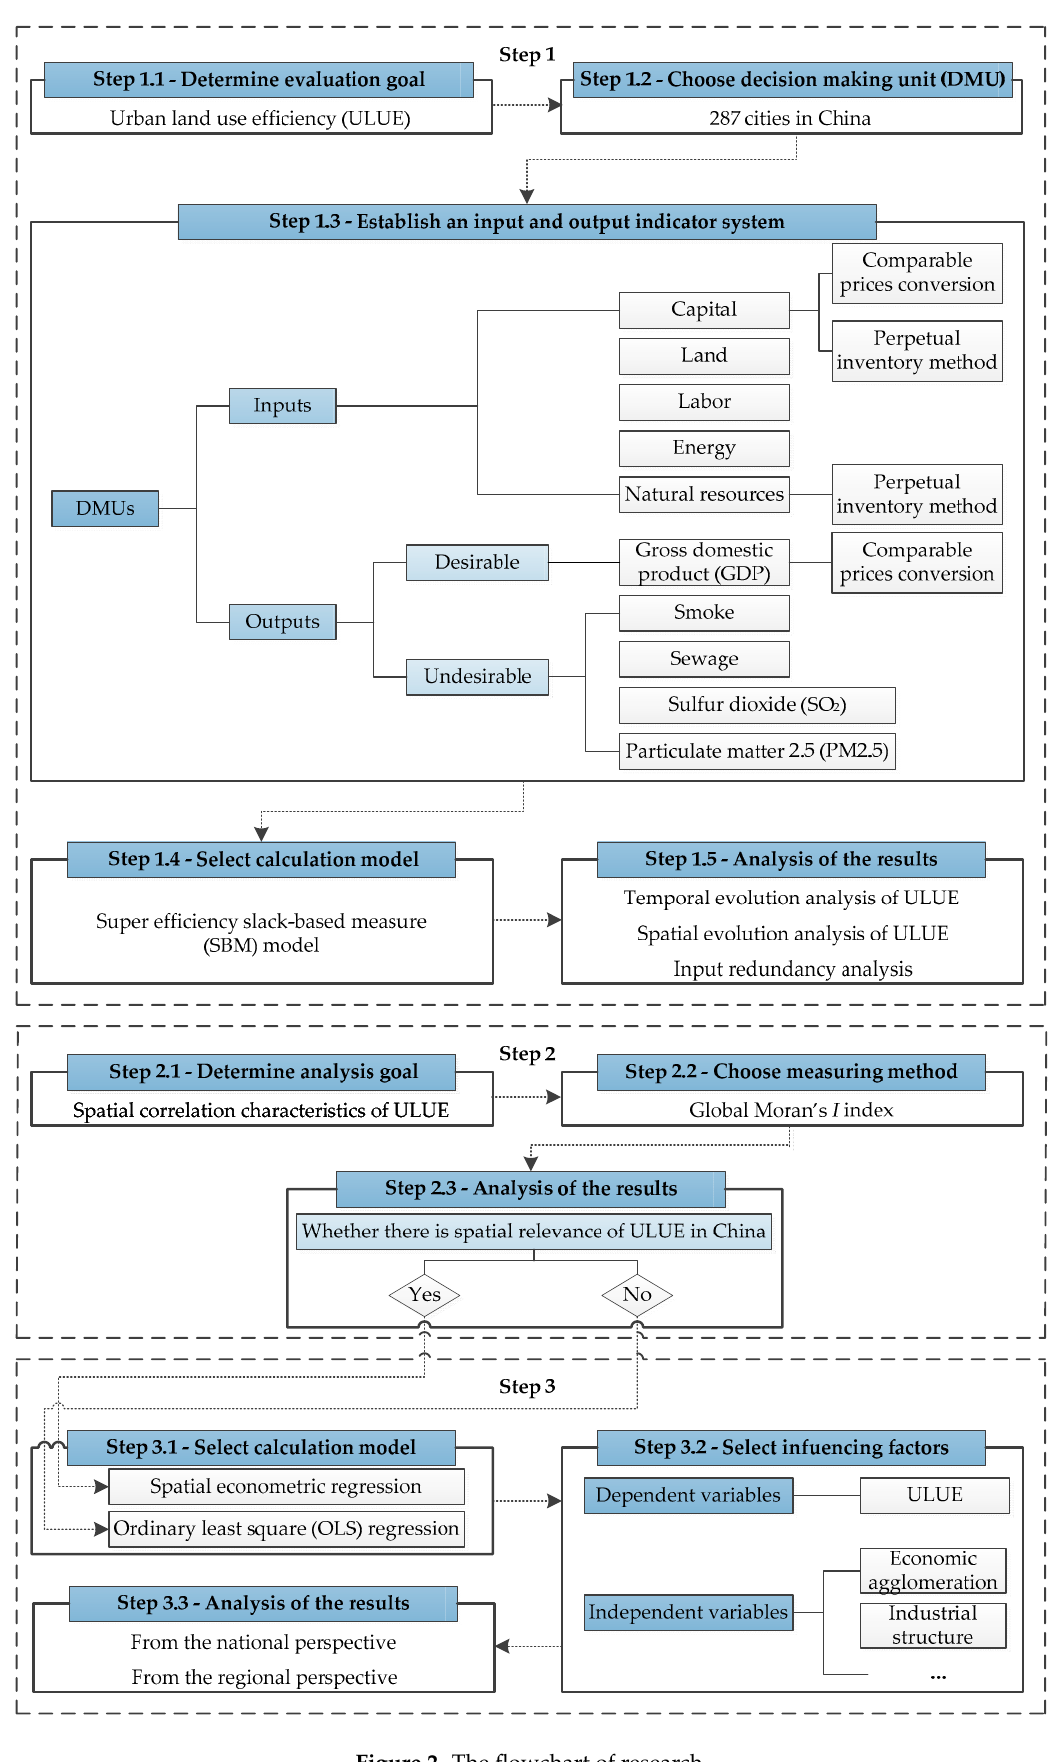
Figure 2. The flowchart of research.